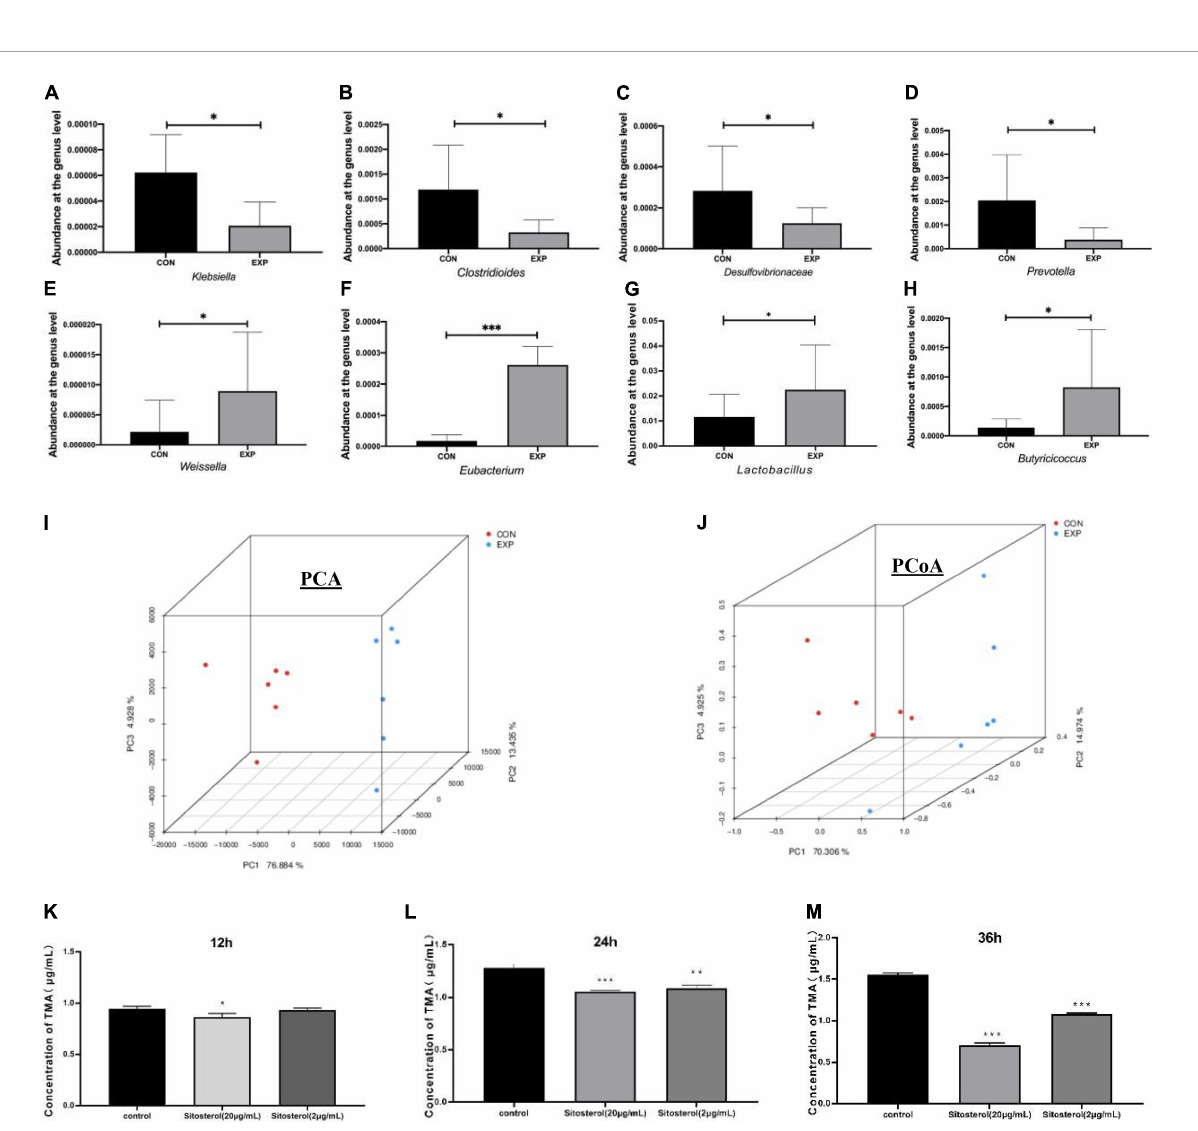
FIGURE5 β -sitosterol decreased trimethylamine (TMA) production by remodeling the gut microbiota in ApoE − / − mice (A–H) comparison of abundant components of the microbiome at the family level between the Con and Exp groups ( n = 6 for each group). (I) Principal component analysis (PC1 76.88% vs. PC2 13.44%). (J) Principal coordinates analysis (PCoA1 70.31% vs. PCoA2 14.97%). (K–M) TMA concentrations at 12, 24, and 36 h of β -sitosterol treated groups in the TMA-producing strain. Values are presented as the mean ± SD. ∗ p < 0.05; ∗∗ p < 0.01; ∗∗∗ p <